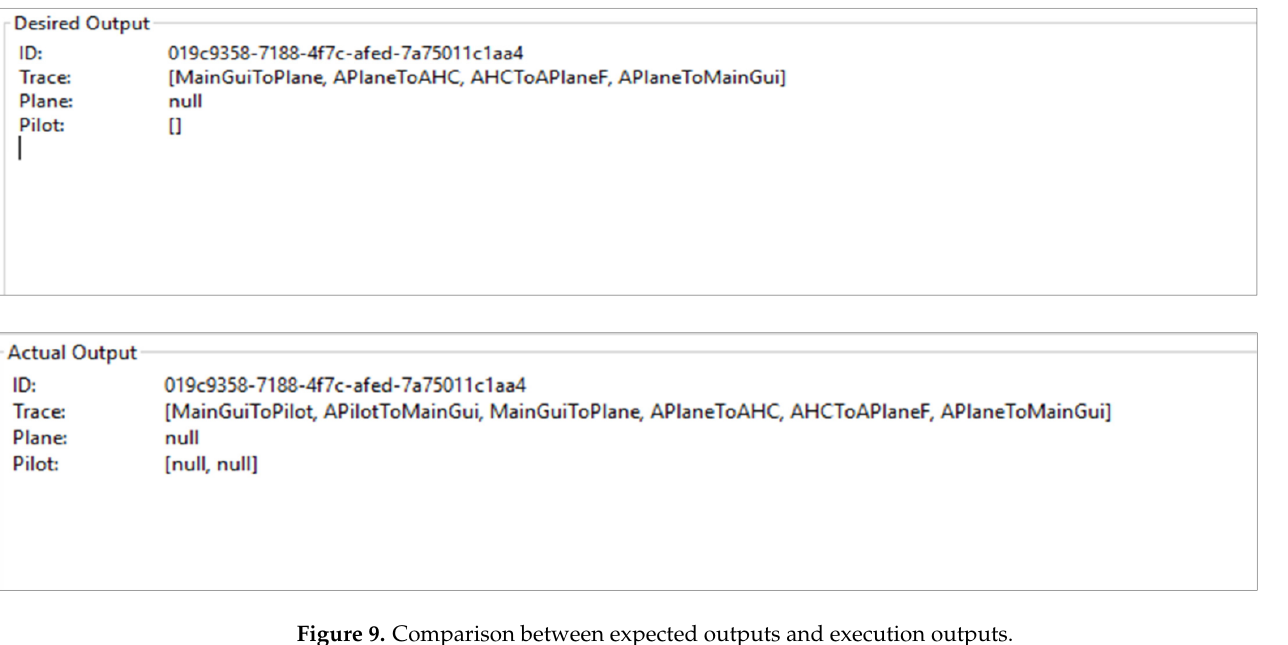
Figure 9. Comparison between expected outputs and execution